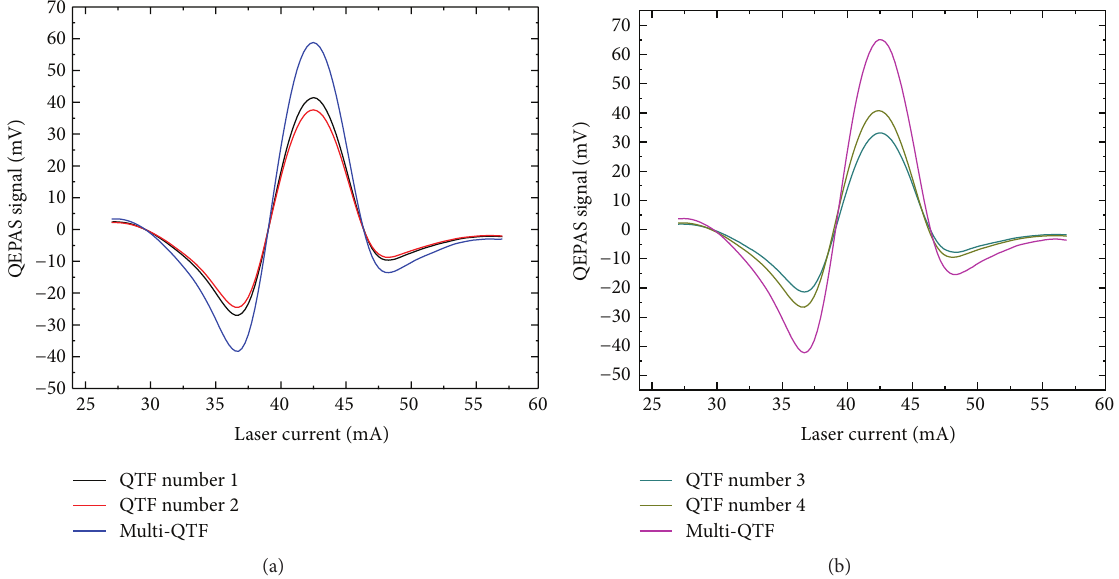
Figure 8: (a) Performance of multi-QTF based “on-beam” spectrophone shown in Figure 4(c); (b) performance of multi-QTF based “on- beam” spectrophone shown in Figure